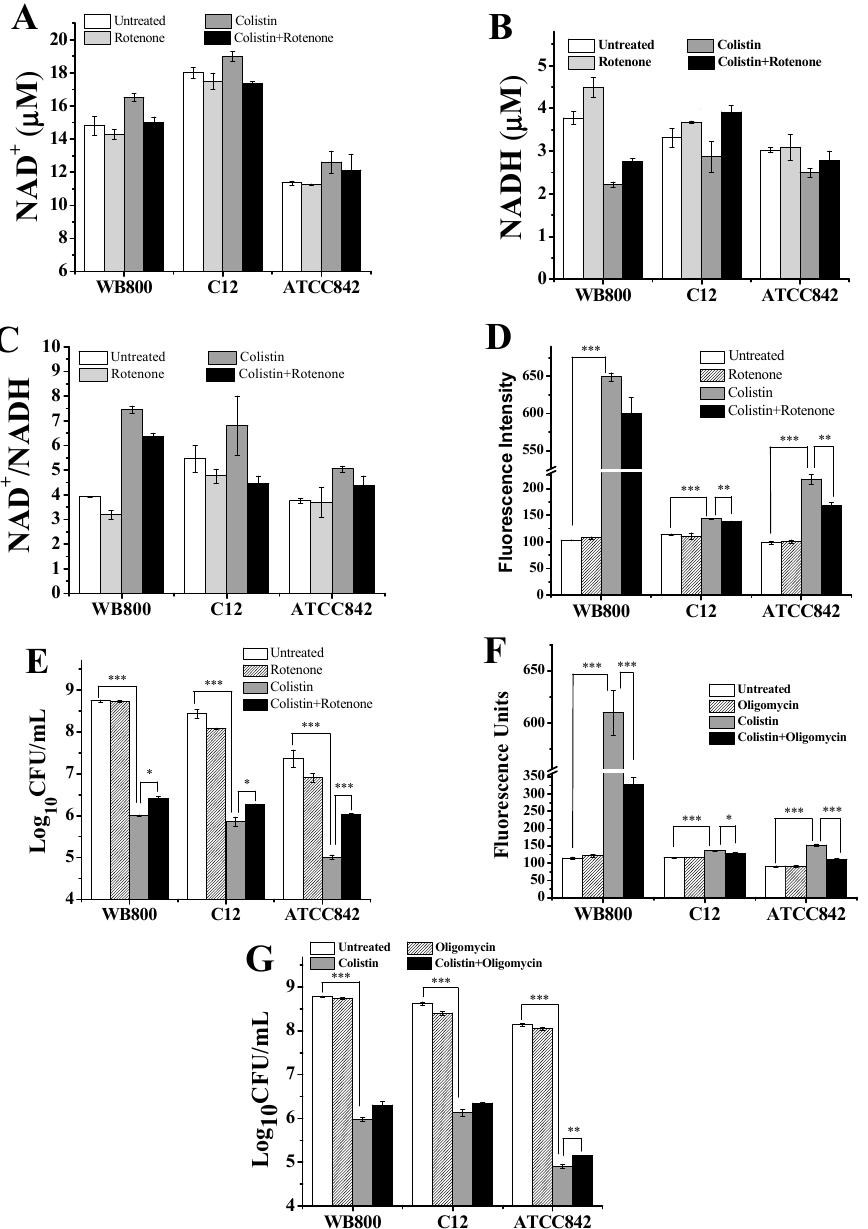
Figure 6. Enhanced NADH metabolism induced by colistin results in oxidative stress and killing of Gram-positive bacteria. ( A ) Changes in NAD + content in cells when exposed to colistin with or without rotenone; ( B ) changes in NADH content in cells when exposed to colistin with or without rotenone; ( C ) changes in NAD + /NADH ratio in cells when exposed to colistin with or without rotenone; ( D ) changes in hydroxyphenyl fluorescein (HPF) signal resulted from hydroxyl radicals formation in cells when exposed to colistin with or without rotenone; ( E ) changes in colony-forming units (CFU) of cells when exposed to colistin with or without rotenone; ( F ) changes in HPF signal resulted from hydroxyl radicals formation in cells when exposed to colistin with or without oligomycin; ( G ) changes in CFU of cells when exposed to colistin with or without oligomycin. Colistin: 1 × 10 4 U/mL, 8 × 10 4 U/mL and 6 × 10 4 U/mL for WB800, C12 and ATCC842, respectively; rotenone: 6 mg/L; oligomycin: 0.6 mg/L. When the probability ( p -value) was less than 0.05, 0.01 and 0.001, the values were considered significantly (*), very significantly (**) and extremely significantly (***) different, respectively. WB800: Bacillus subtilis WB800; C12: Paenibacillus polymyxa C12; ATCC842: Paenibacillus polymyxa